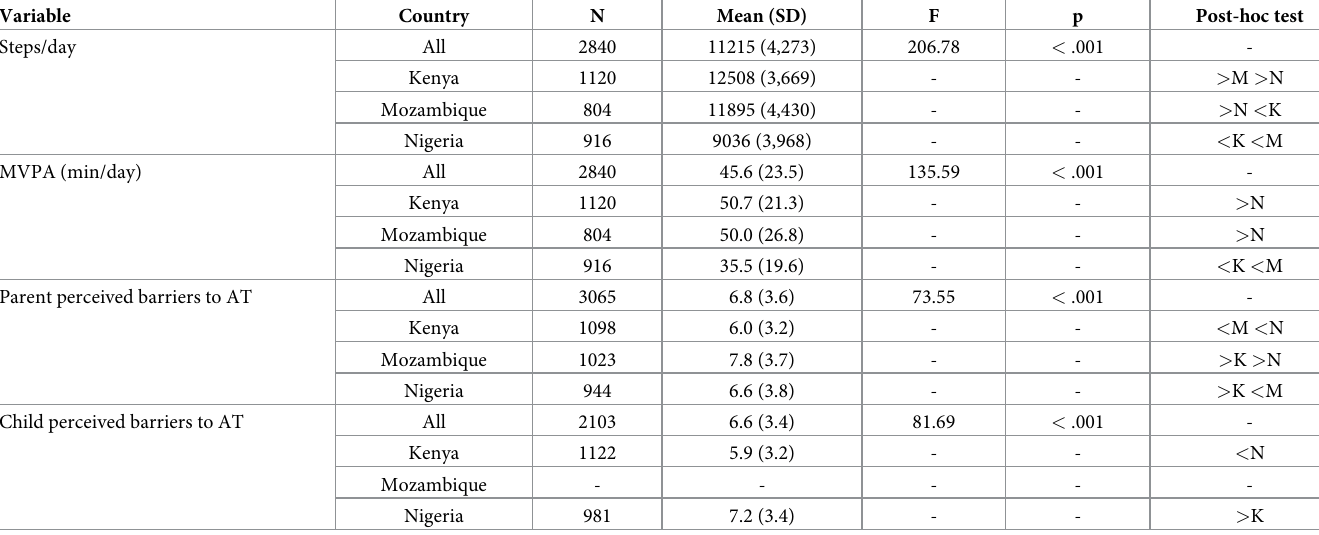
Table 2. Differences between countries in measures of PA and perceived barriers to AT. Variable